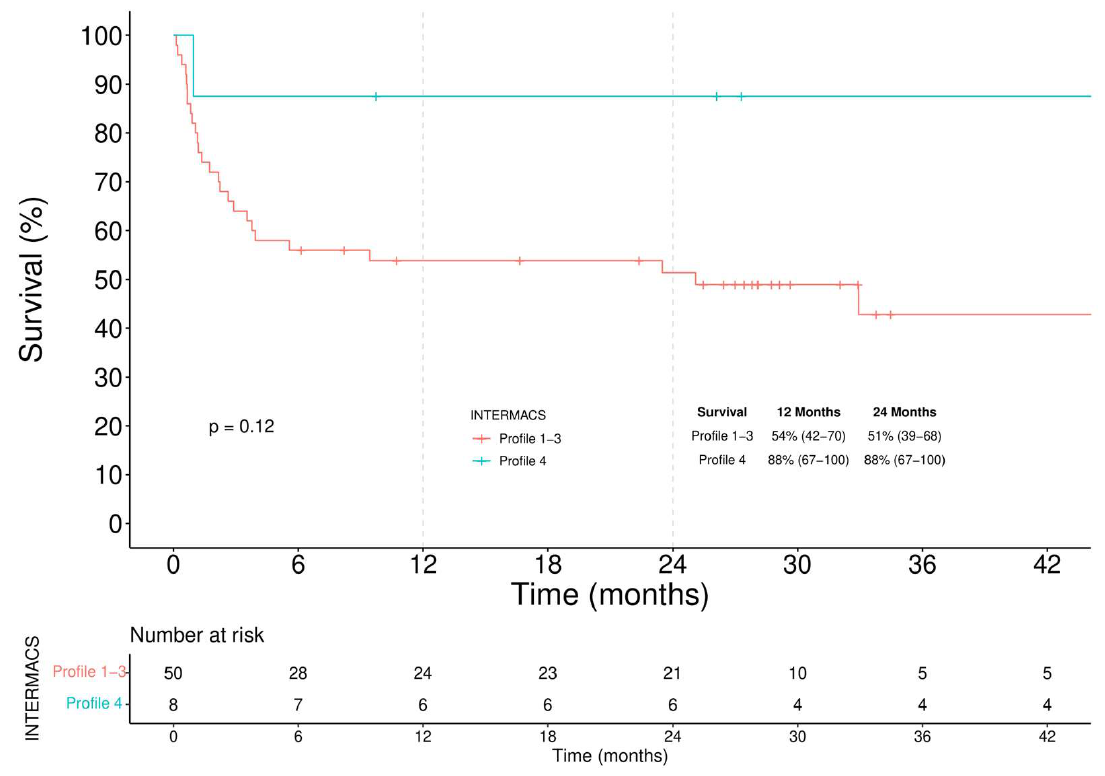
Figure 5. Competing risk analysis in BTT patients: curves are used to represent the cumulative risk of a patient during the time of being alive, transplanted, or dead.